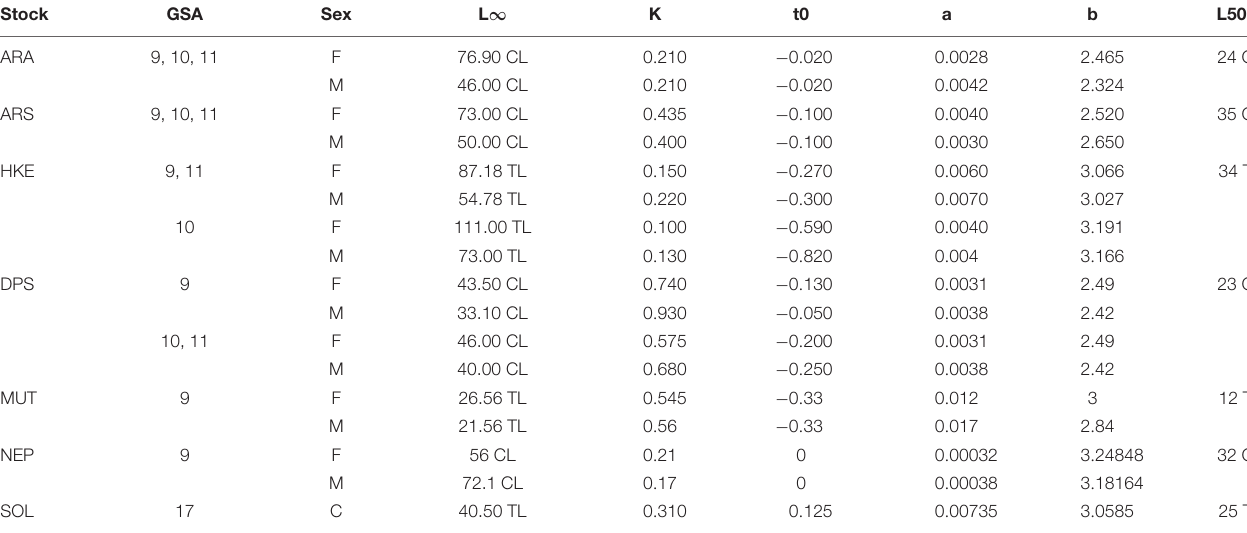
TABLE 1 | Main biological parameters for the 7 stocks Blue and red shrimp (ARA), Giant red shrimp (ARS), Deep-water rose shrimp (DPS) and European hake (HKE) in the FAO GSAs 9,10 and 11, Red mullet (MUT) and Norway lobster (NEP) in FAO GSA 9 and Common sole (SOL) in FAO GSA 17. Stock GSA